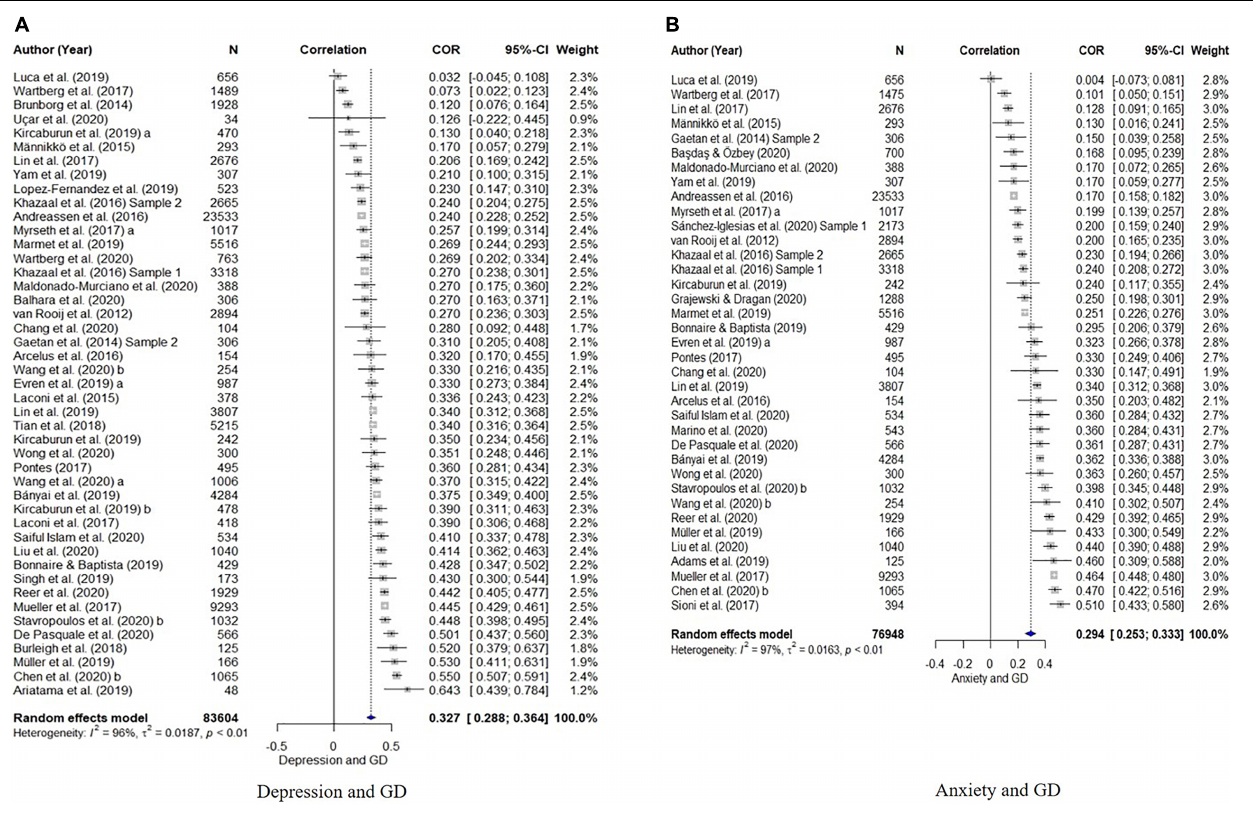
95% CI Heterogeneity